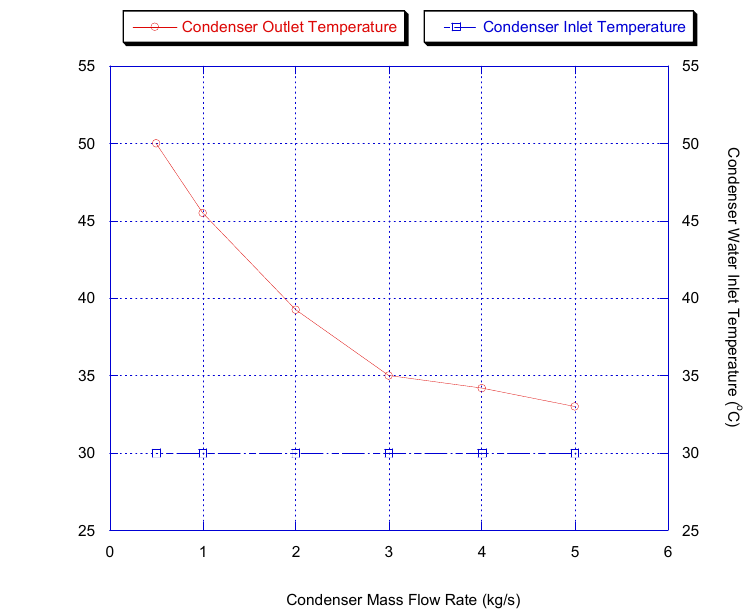
Figure 11. Effect of condenser water flow rate on condenser outlet temperature (results are at chiller nominal operating conditions, shown in Appendix B).